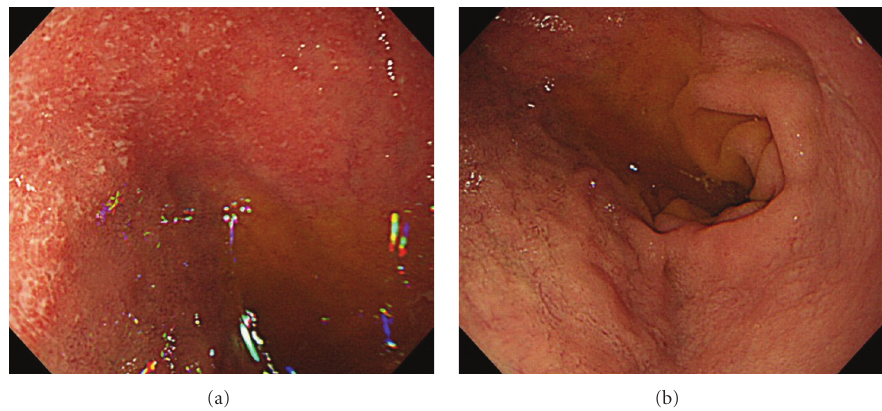
Figure 3: (a) Endoscopy of the upper gastrointestinal tract showed multiple small erosions in the duodenal bulb that were similar in appearance to colonic lesions of UC. (b) Endoscopic findings of the descending portion of the duodenum showed di ff use granular changes.